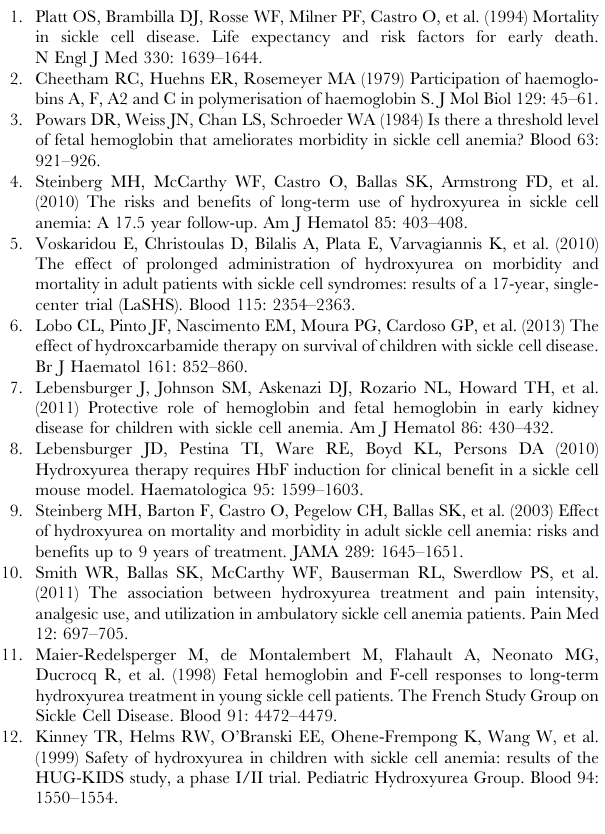
Table S1 Quality control filters used in WES